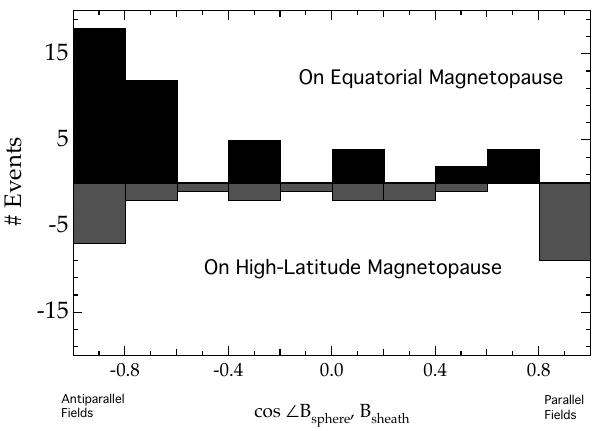
Fig. 12. Event occurrence versus the cosine of the shear angle between the magnetosheath and magnetospheric magnetic fields. Events on the equatorial magnetopause show a strong tendency to occur for high shears, while those on the high-latitude magne- topause exhibit a marked tendency to occur for both strongly and weakly sheared magnetic